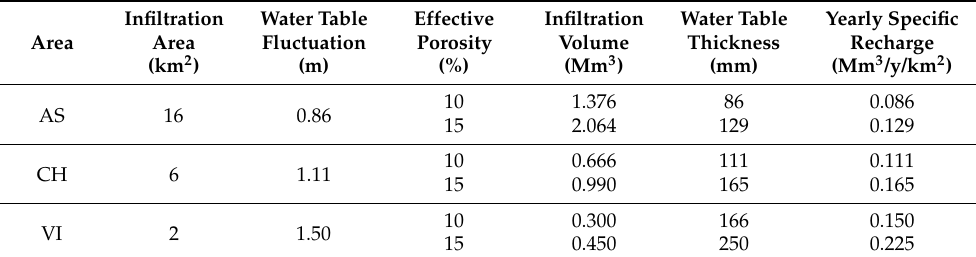
Table 9. Water table fluctuation and yearly specific recharge results.